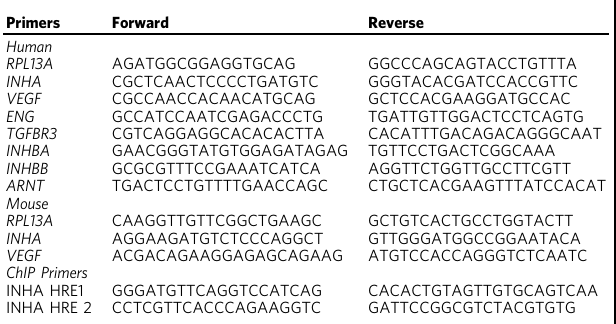
Table 2 qRT-PCR primer